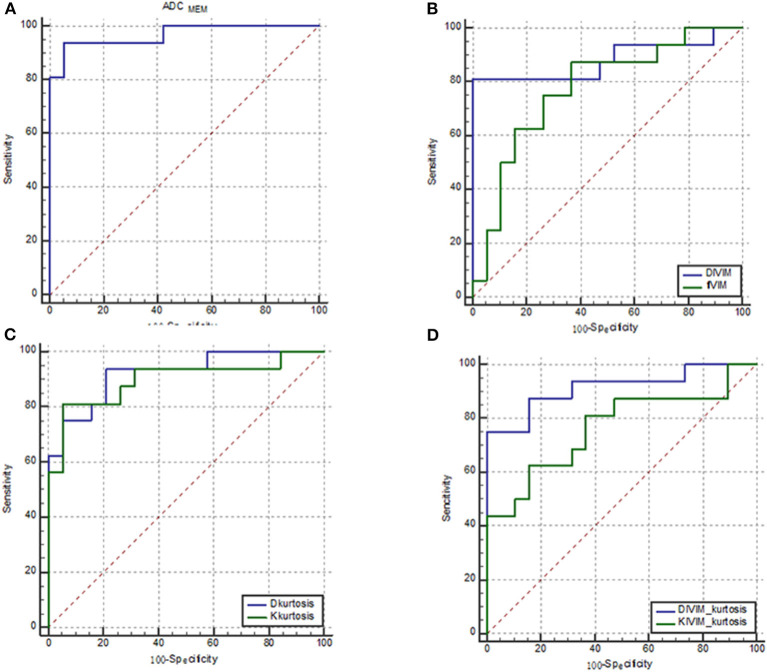
ROC curves of various parameters for identifying PCa. (A) ADCMEM; (B)
DIVIM and fIVIM, which were derived from the IVIM model; (C)
Dkurtosis and Kkurtosis, which were derived from the kurtosis model; and (D)
DIVIM−kurtosis and KIVIM−kurtosis, which were derived from the IVIM–kurtosis model. The AUC of ADCMEM, DIVIM, fIVIM, Dkurtosis, Kkurtosis, DIVIM−kurtosis, and KIVIM−kurtosis was 0.967, 0.882, 0.773, 0.921, 0.898, 0.914, and 0.766, respectively.